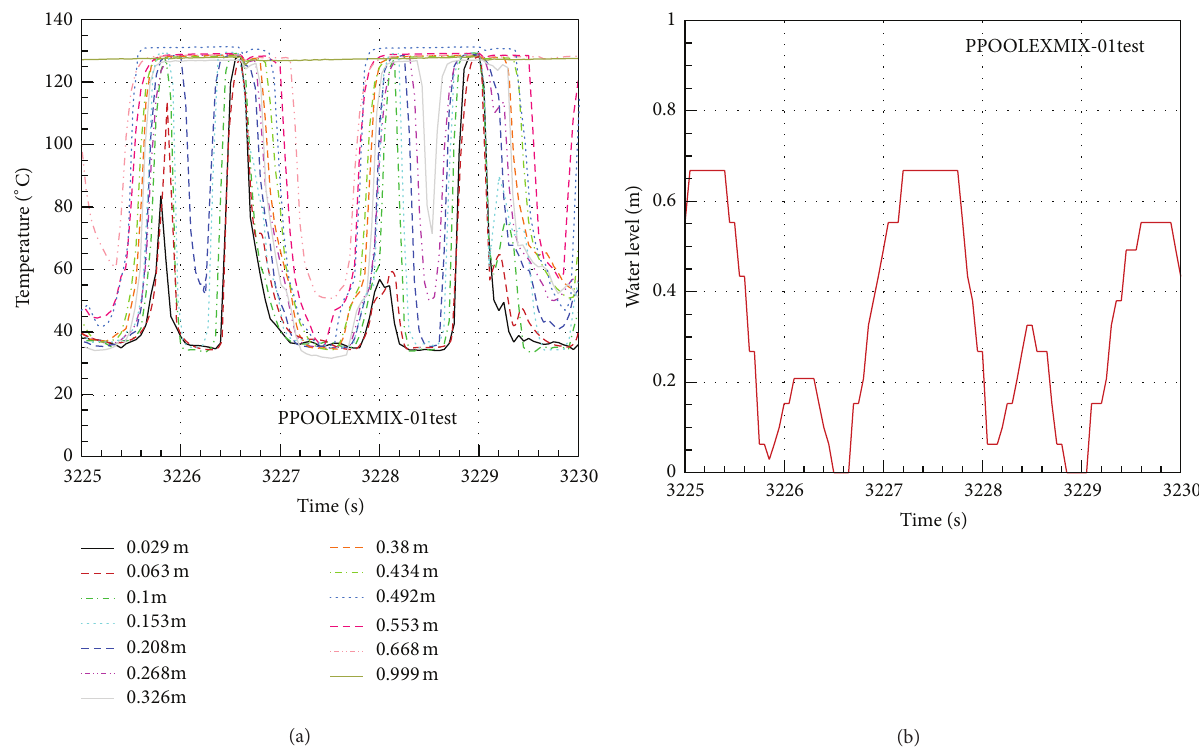
Figure 8: (a) TC measurements inside the blowdown pipe and corresponding (b) water level positions for a 5s time window and superimposed smoothed data with a moving average filter. Frequency and amplitude of oscillations can be based on the water level positions inside the pipe. The outlet of the pipe is at 0 m.